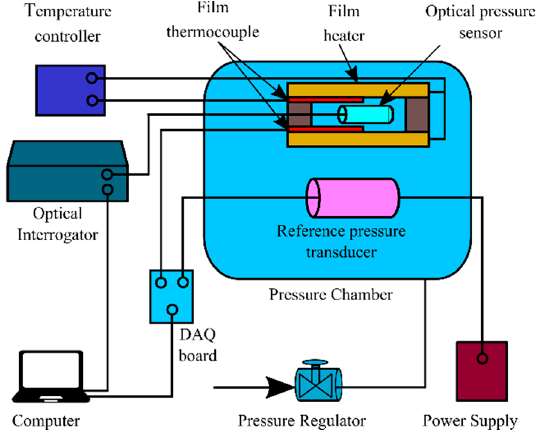
Figure 3. Experiment arrangement for pressure and temperature calibration.